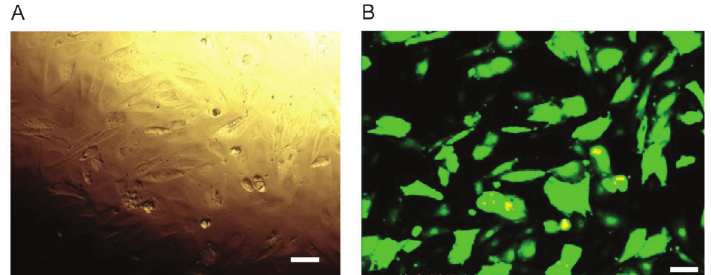
Figure 2. Morphology of bone marrow progenitor cells 48 h after infection with Ad-BMP2-bFGF-GFP at a multiplicity of infection (MOI) value of 5000. A , Image under light microscope. B , Image under fluorescence microscope showing the expres- sion of green fluorescent protein-positive cells. Bar = 50 m